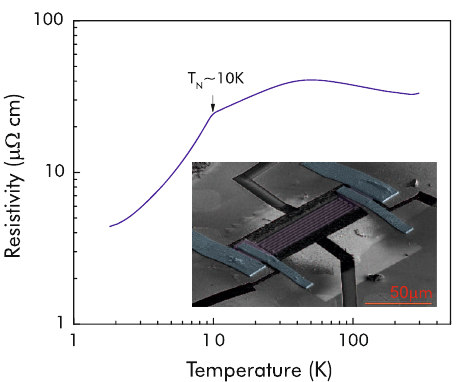
Fig. 1 Resistivity of a CeIn 3 microstructure as a function of temperature in zero fi eld. Both the characteristic upturn of resistance down to 70 K as well as the sharp drop of resistance at T N ≈ 10 K are characteristic features of bulk CeIn 3 . Inset : SEM micrograph of a typical microstructure fabricated by FIB machining, designed for a four-terminal resistivity measurement. The crystalline material was patterned into a meandered resistor shape ( purple ) and contacted by FIB-deposited platinum leads ( blue )